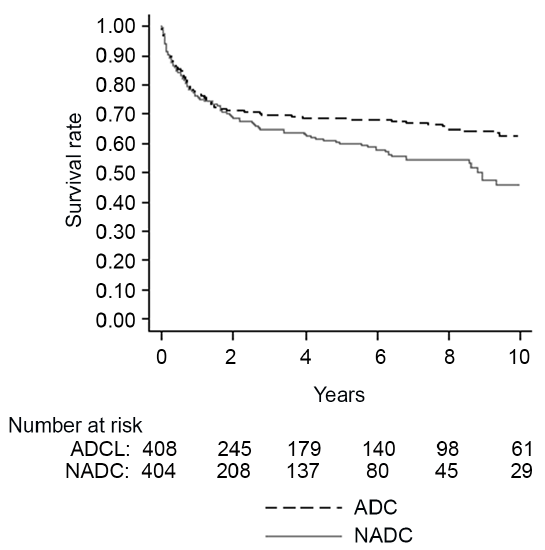
Figure 1. Survival probabilities according to cancer classifica- tion. ADC, AIDS-defining cancer. NADC, non-AIDS-defining cancer.